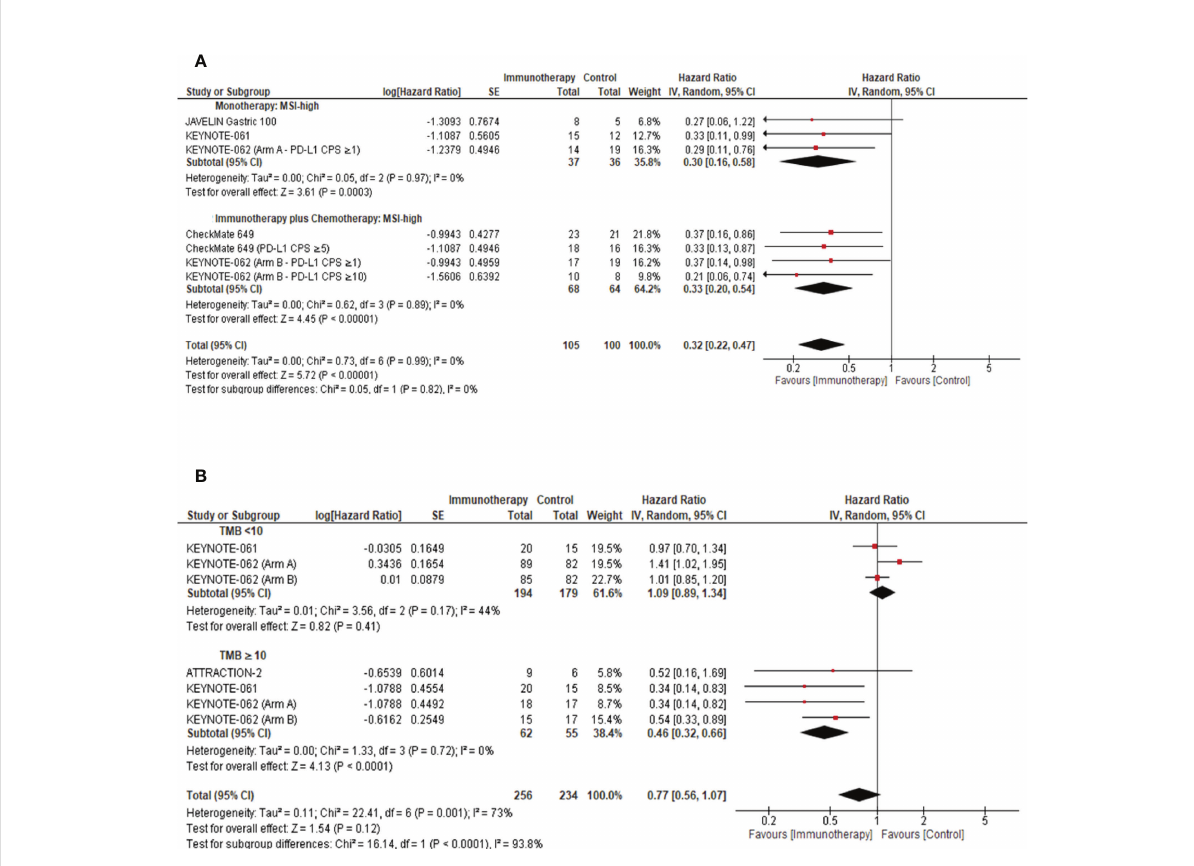
FIGURE 4 Role of tissue biomarkers on response to ICIs in advanced gastric cancer. (A) Forest plot to demonstrate the impact of MSI on Overall Survival in the intention to treat population. (B) Forest plot to demonstrate the effect of TMB on the Overall Survival in the intention to treat population. MSI, microsatellite instable; TMB, tumor mutational burden; CI, con fi dence